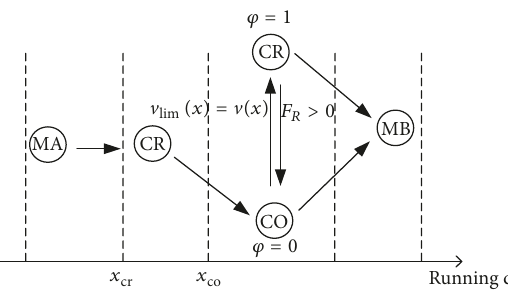
Figure 3: Transitions of train control modes with the improved